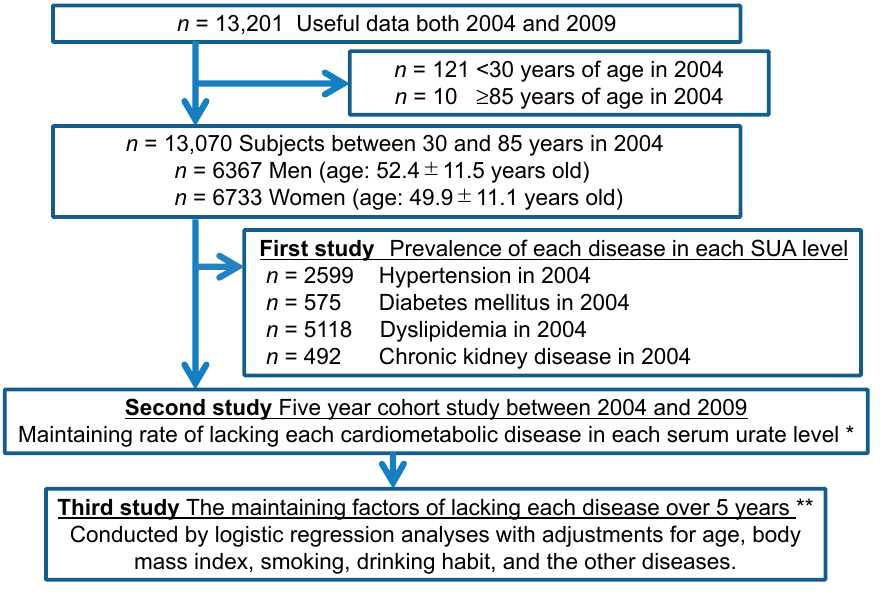
Figure 1. Flow diagram of study enrollment. All the analyses were stratified by sex. * Each cardiometabolic disease means hypertension, diabetes, dyslipidemia and chronic kidney disease. ** The number of subjects depends on the excluded subjects having the corresponding disorders at